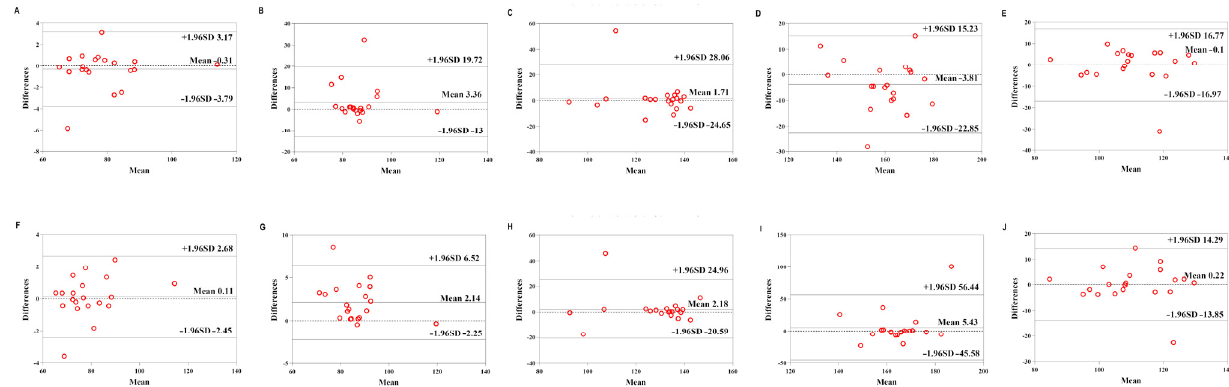
Figure 5. Comparison between the Lexin Mio smart bracelet (Mio) and Polar Heart Rate Monitor (Polar) for heart rate (HR) in the high-physical-activity level (HPAL) group. ( A ) Bland–Altman plots of mean of left Mio and Polar for HR under rest condition. ( B ) Bland–Altman plots of mean of left Mio and Polar for HR under the low-intensity exercise. ( C ) Bland–Altman plots of mean of left Mio and Polar for HR under the middle-intensity exercise. ( D ) Bland–Altman plots of mean of left Mio and Polar for HR under the high-intensity exercise. ( E ) Bland–Altman plots of mean of left Mio and Polar for HR under recovery condition. ( F ) Bland–Altman plots of mean of right Mio and Polar for HR under rest condition. ( G ) Bland–Altman plots of mean of right Mio and Polar for HR under the low-intensity exercise. ( H ) Bland–Altman plots of mean of right Mio and Polar for HR under the middle-intensity exercise. ( I ) Bland–Altman plots of mean of right Mio and Polar for HR under the high-intensity exercise. ( J ) Bland–Altman plots of mean of right Mio and Polar for HR under recovery condition.